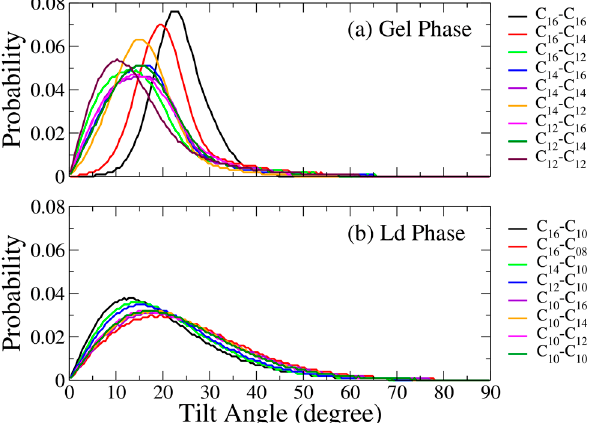
Figure 5. Tilt angle distribution for all the tested C m TMA + -C n S − IPA bilayer systems ( a ) in gel (S) phase and ( b ) in liquid-disordered (Ld) phase.